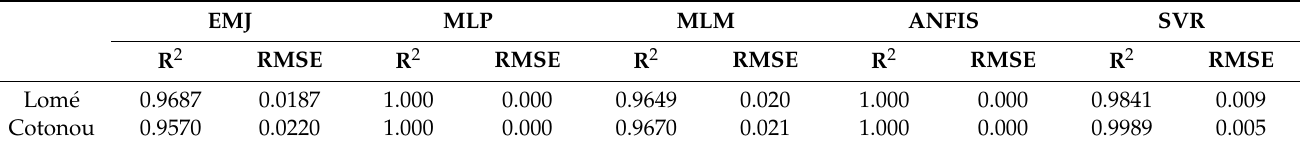
Table 10. Method comparison.